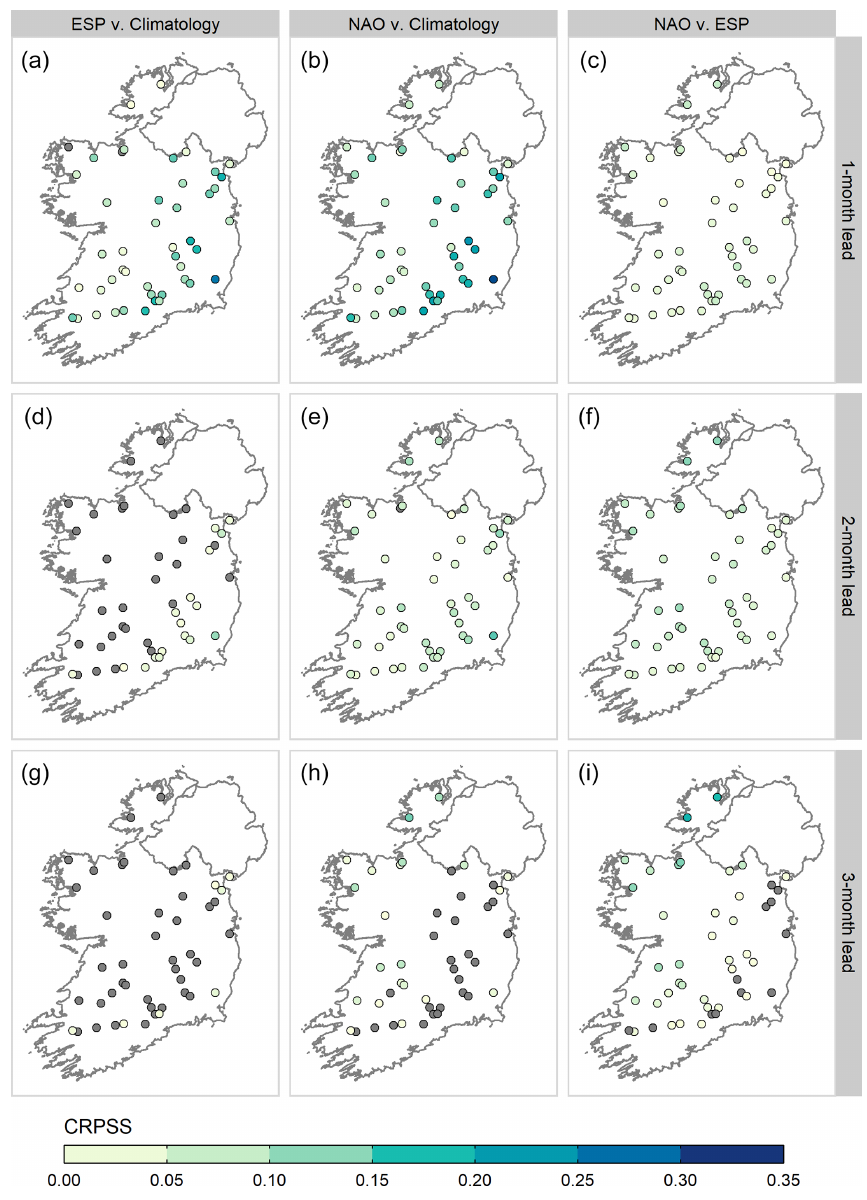
Figure 10. CRPSS values for historical ESP (a, d, g) , NAO-conditioned ESP (b, e, h) , and the improvement made by NAO-conditioned ESP over historical ESP (c, f, i) , at lead times of 1, 2, and 3 months (rows). Catchments with negative skill (CRPSS < 0) are greyed out.